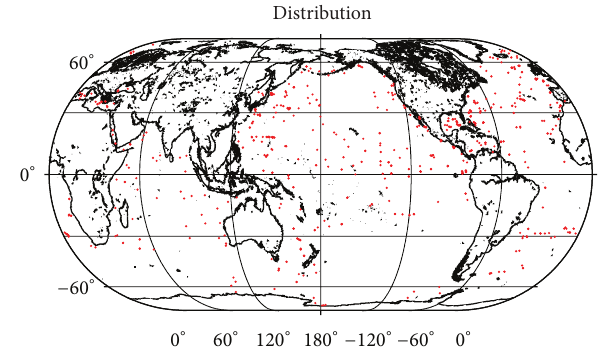
Figure 1: Location map of the 716 DSDP drill sites.